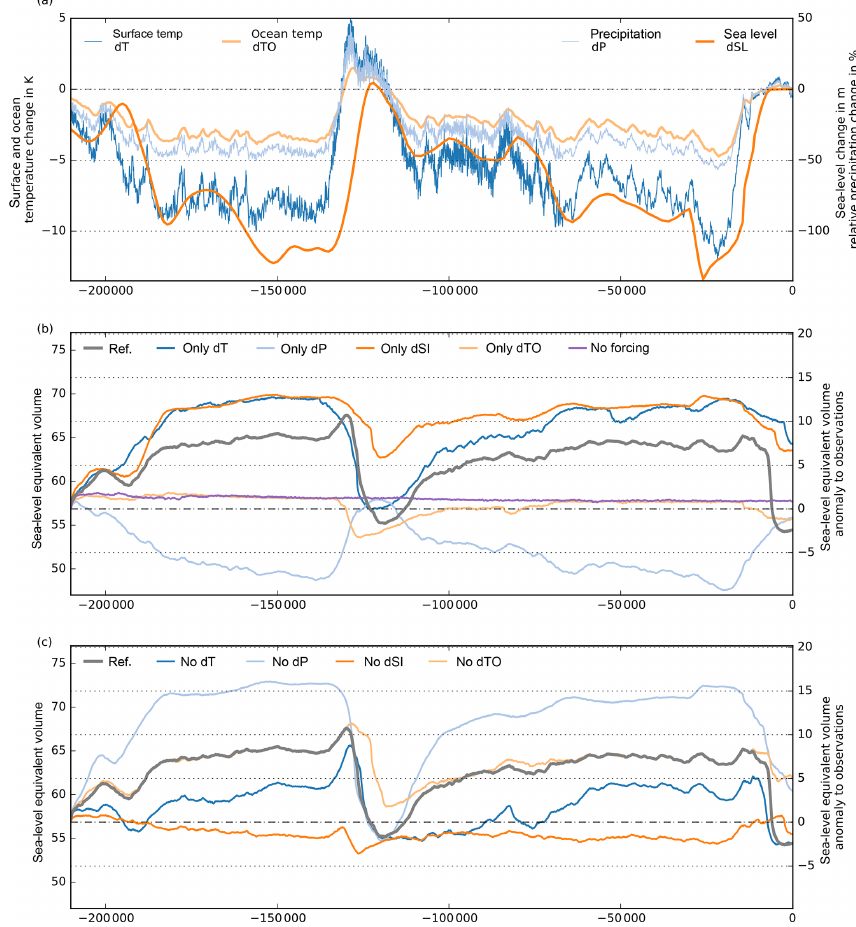
Figure 24. Antarctic Ice Sheet volume above flotation for combinations of surface temperature, ocean temperature, sea-level and precipitation forcings (a) , as defined in previous sections. (b) The ice sheet’s response to individual forcings (or constant equilibrium conditions in purple) or (c) in the absence of one of the forcings, compared to the reference simulation (with all forcings combined; in grey). Sea-level forcing (orange) and surface temperature forcing (blue) have the strongest effects: each alone can cause larger glacial ice volume than in the reference simulation. However, each alone cannot initiate effective glacial retreat during modern climate. In contrast, ocean temperature forcing (light orange) has no effect on glacial volume, but it amplifies deglaciation. Precipitation forcing (light blue) counteracts sea-level and temperature forcings in glacial